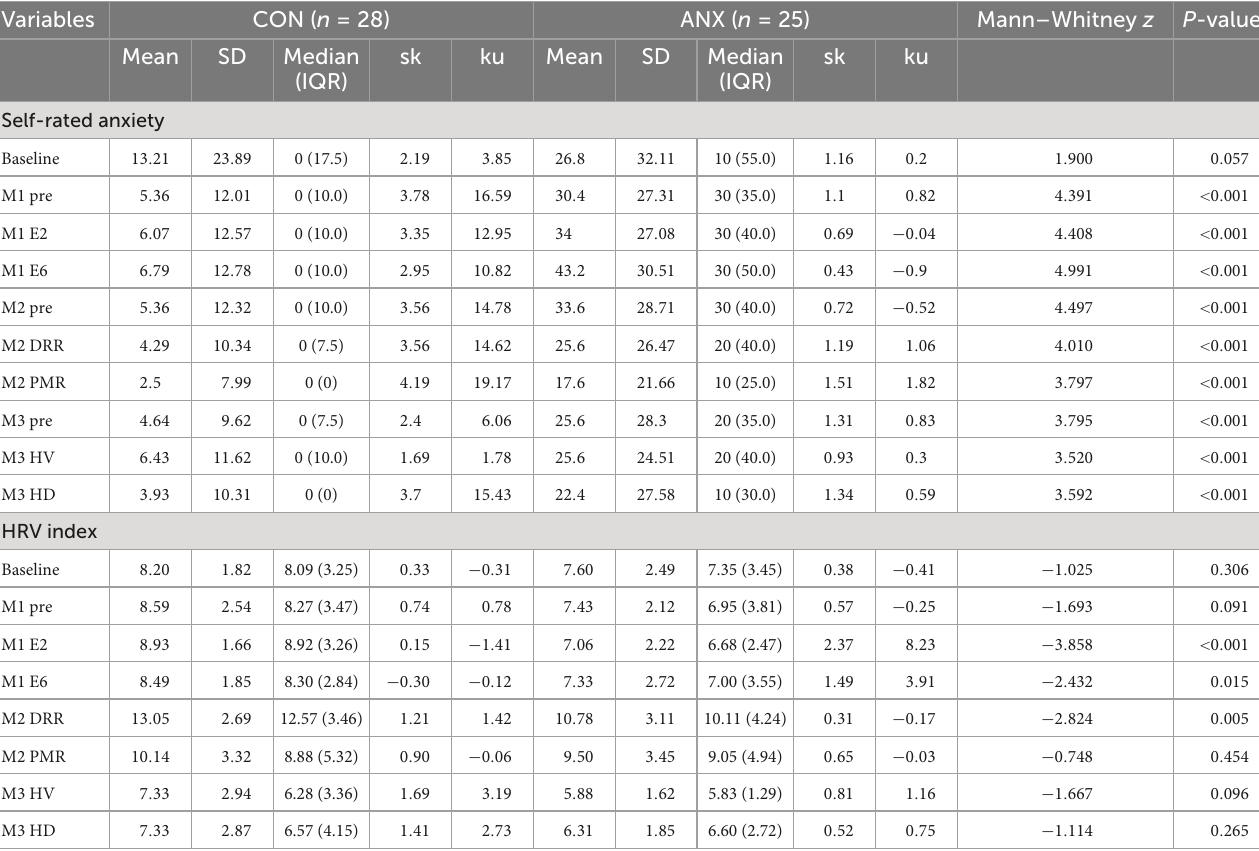
TABLE 2 Distribution and descriptive statistics of the psychophysiological data in each module.